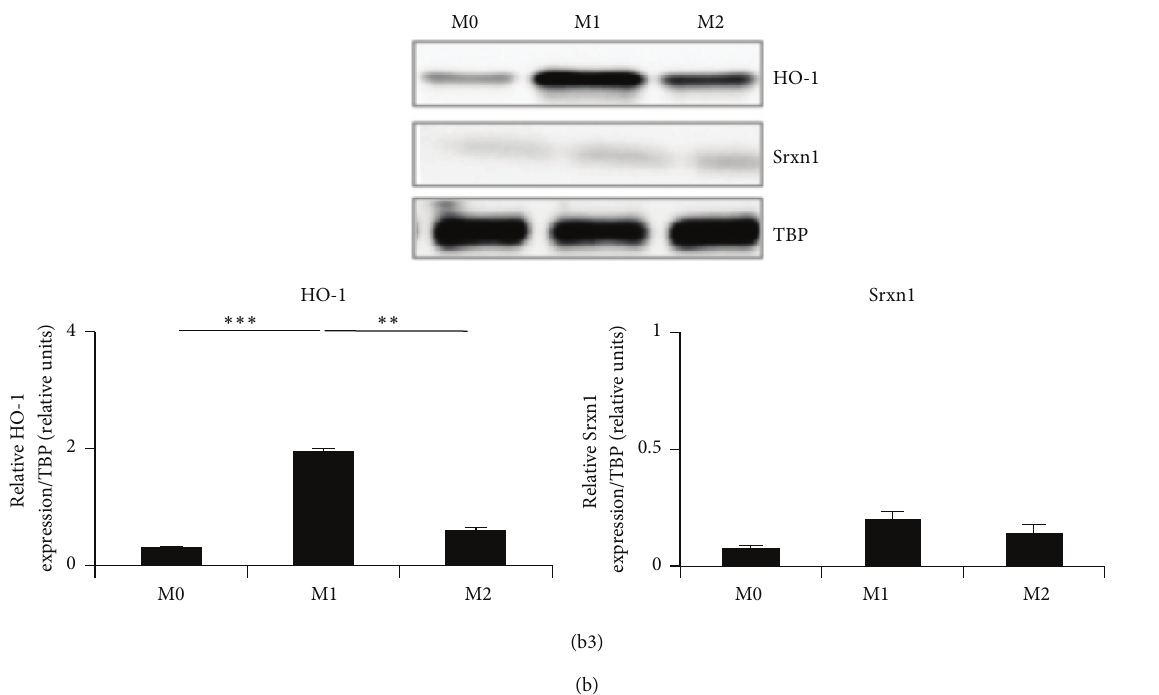
Figure 1: Characterization of RAW 264.7 M0, M1 (LPS + IFN- 𝛾 ), and M2 (IL-4 + IL-13) polarized macrophages. Cells were polarized as described in Materials and Methods. (a) Expression of polarization marker genes at the mRNA level (RT-qPCR), in M0, M1, and M2 macrophages. The expression of iNOS and IL-6 as M1 markers, Arg1 and MRC1 as M2 markers, and HO-1 and Srxn1 as MOX redox-sensitive markers was analyzed by RT-qPCR. Data were normalized with TBP used as housekeeping gene and expressed as mean fold induction relativelytoM0cells ± SD( 𝑛 = 3 ).(b)ExpressionofpolarizationmarkersattheproteinlevelinM0,M1,andM2macrophages.(b1)Production of secreted IL-6 (M1 marker) in cell culture supernatants assessed by ELISA. Data are expressed relatively per 𝜇 g of protein per well as mean ± SD ( 𝑛 = 3 ). (b2) Surface expression of MRC1 (M2 marker) analyzed by flow cytometry in M0, M1, and M2 macrophages (m 𝜑 ). GMF , 65.57 and Δ GMF M 1 , 28.9. The data (geometric mean of the fluorescence intensity) values are reported in arbitrary units: Δ GMF M 2 - M 0 - M 0 presented are representative of 3 independent experiments. (b3) Expression of HO-1 and Srxn1 assessed by Western blotting in M0, M1, and M2 macrophages. Data are normalized with TBP used as loading control and expressed as mean ± SD ( 𝑛 = 3 ). Results are representative of 3 independent experiments. ANOVA 1: ∗∗ 𝑝 < 0.01 and ∗∗∗ 𝑝 < 0.001